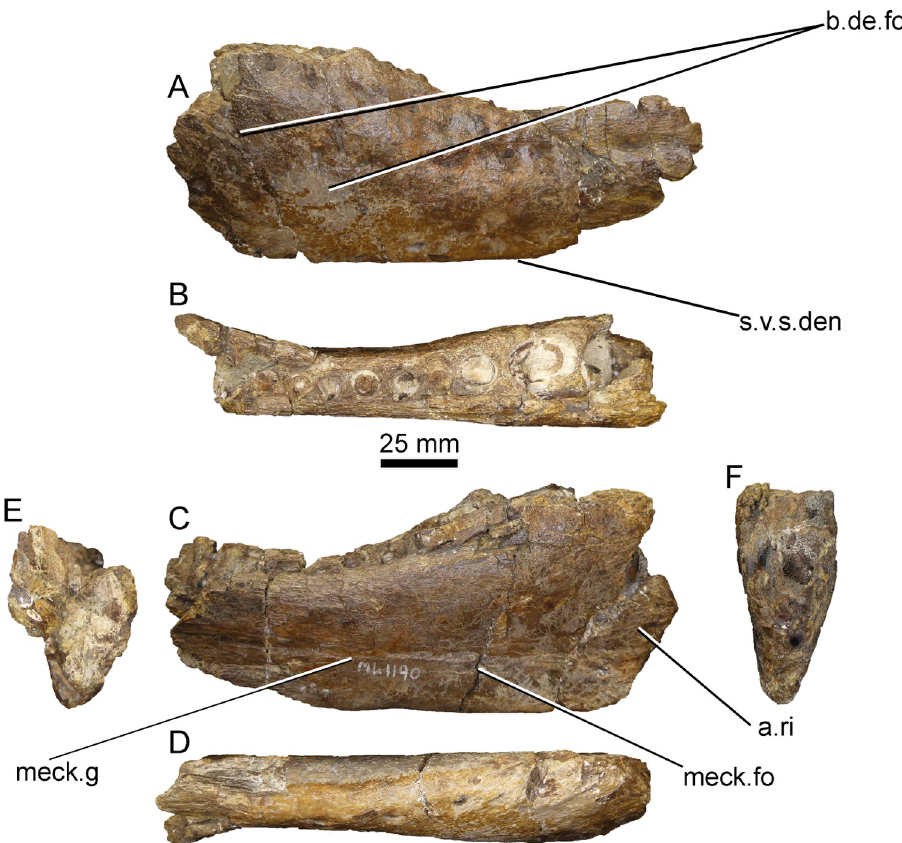
Fig 3. Anterior left dentary portion (holotype) of Iberospinus natarioi (ML1190-1). A, lateral, B, dorsal, C, medial, D, ventral, E, posterior, and F anterior views. a.ri , anterior ridges, b.d.fo , lateral dentary foramina, meck.g , Meckelian groove, meck.fo , Meckelian foramen, s.v.s.den , straight ventral surface of the